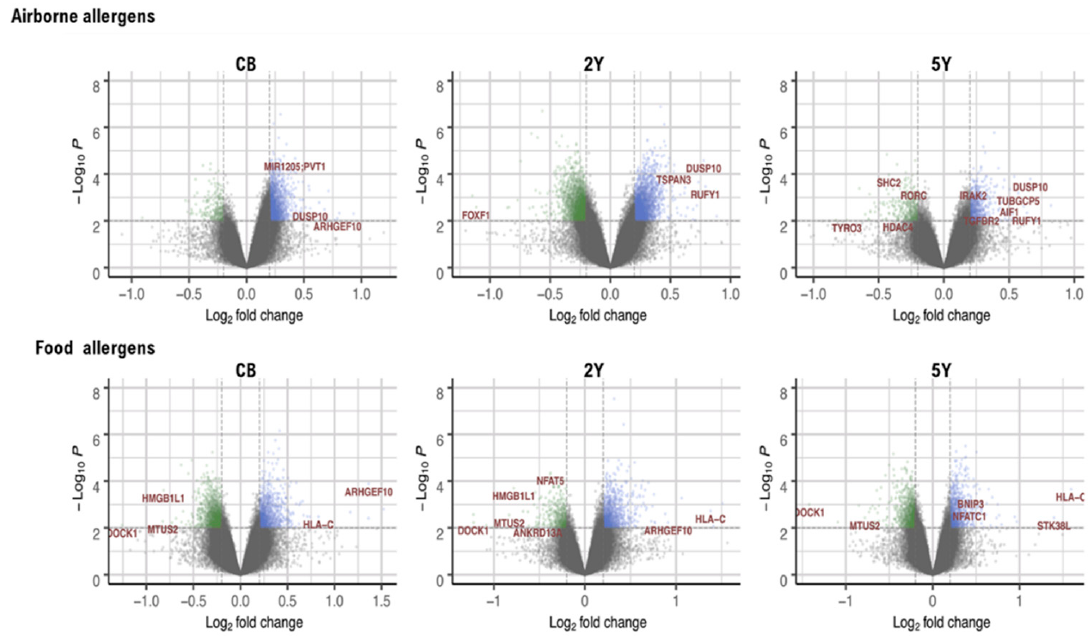
Figure 2. Volcano plots on the differential methylation at different time points for children sensitized to airborne and food allergens. Genes with the largest methylation differences (fold change) are presented in brown labels. Green dots represent DMPs with reduced methylation in sensitized children and blue are DMPs with increased methylation in sensitized children. Dotted lines represent the fold change threshold (0.2, vertical line) and the p -value threshold of <0.01 (horizontal line). CB = cord blood, 2Y = age 2 years, 5Y = age 5 years.